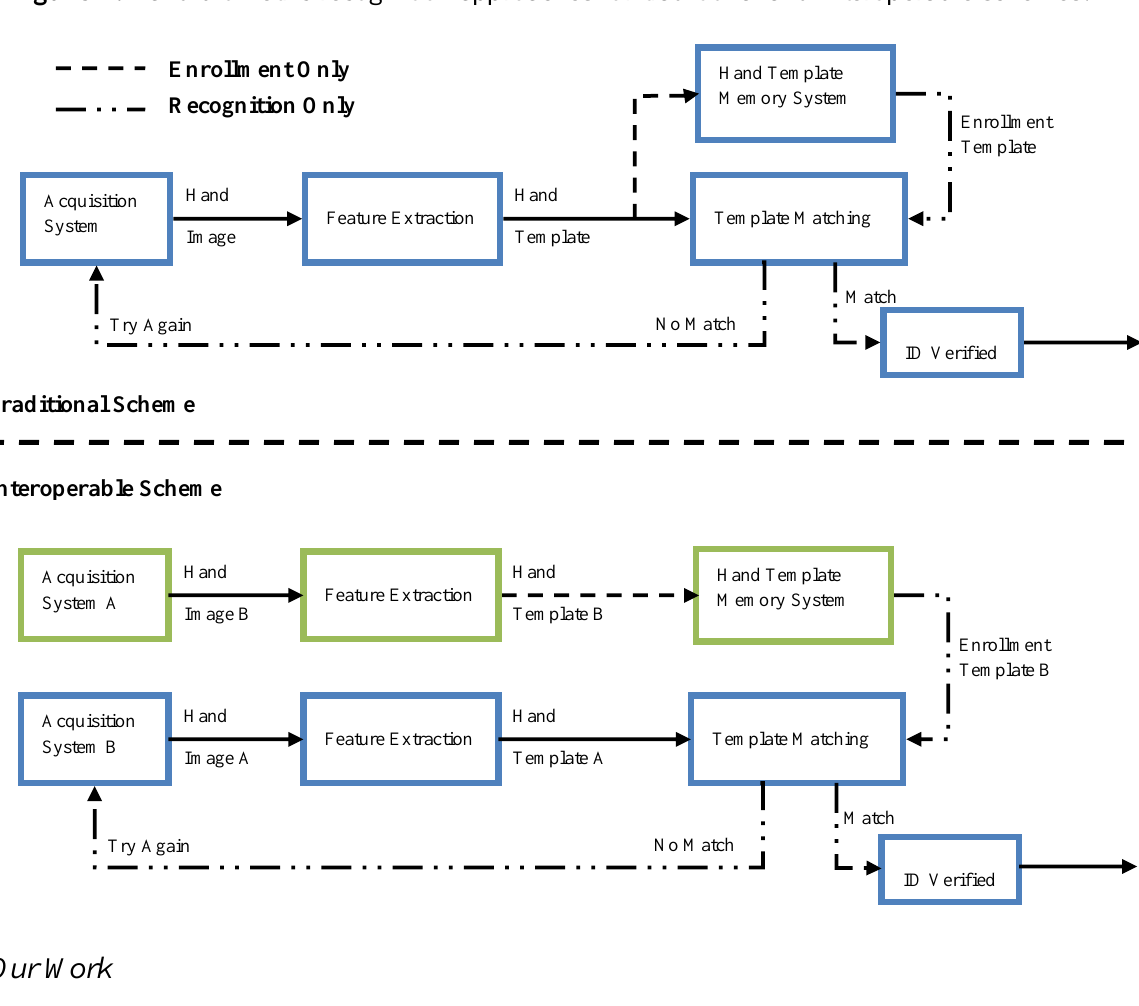
Figure 1. Hand biometric recognition approaches for traditional and interoperable